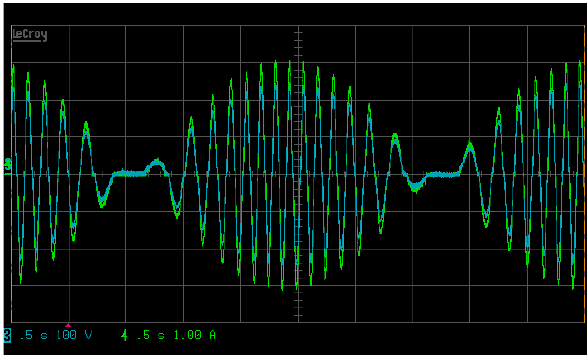
Figure 15. Generator coil current tracks the voltage waveform (one phase).